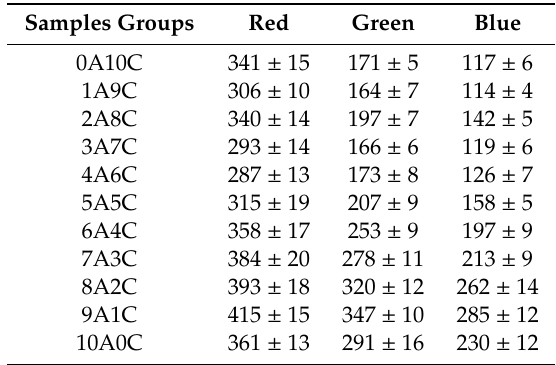
Table 6. Red, Green and Blue coordinates of the color of the di ff erent families of samples conformed with clay and biomass bottom